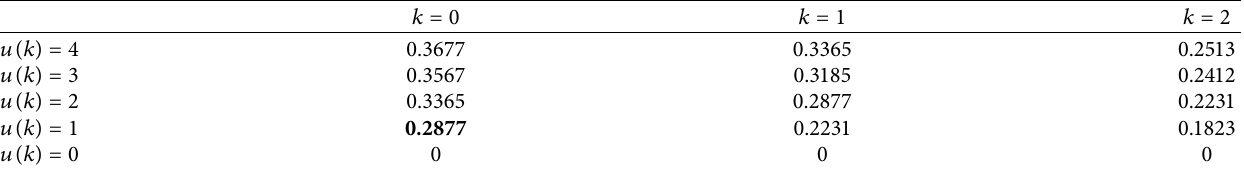
Table 1: Values of L ( u ( k ) ,k ) for various values of u ( k ) .